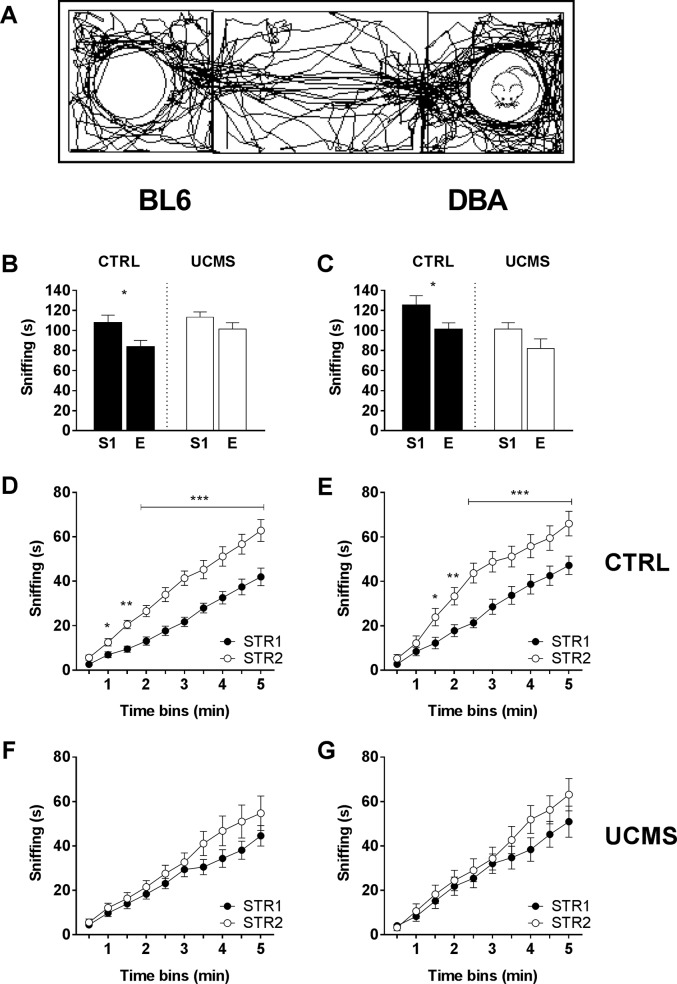
Sociability and preference for social novelty (SPSN).(A) Representative track plot of single sociability trial. (B) During sociability trials, BL6 CTRLS significantly preferred the STR1 (S1) chamber over the empty (E) chamber, whereas UCMS mice showed no preference. (C) Similar results were observed for DBA mice, where the UCMS group showed decreased sociability when compared to CTRLS. (D-F) During preference for social novelty trials, CTRL mice preferred the novel STR2 during social novelty exploration (first 5 min.). UCMS mice showed no clear preference for either STR1 or STR2. Values are expressed as mean +/- SEM. *, p < 0.05; ** p < 0.01; *** p < 0.001.